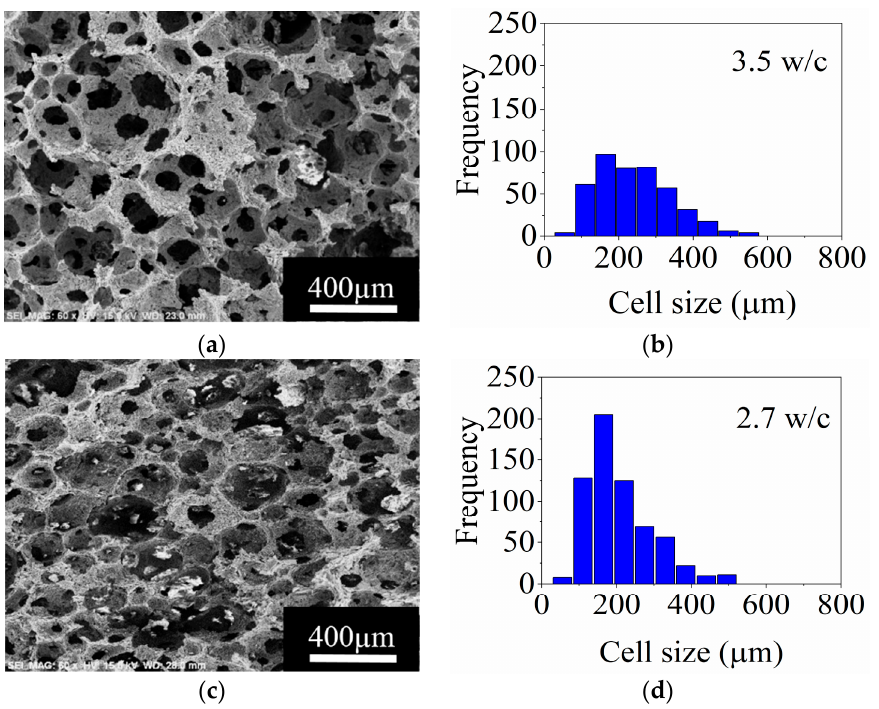
Figure 6. SEM micrographs and frequency histograms for the cell size of ceramic foams obtained using ( a ) and ( b ), 3 wt.% SE; and ( c ) and ( d ), 5 wt.% SE; respectively.